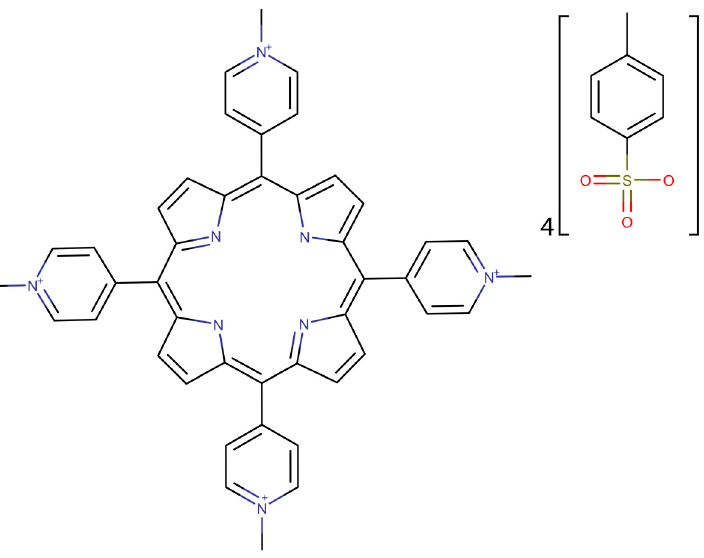
Figure 1. 2D structure of TMPyP4 generated using the SMILES code imported from PubChem database [30].